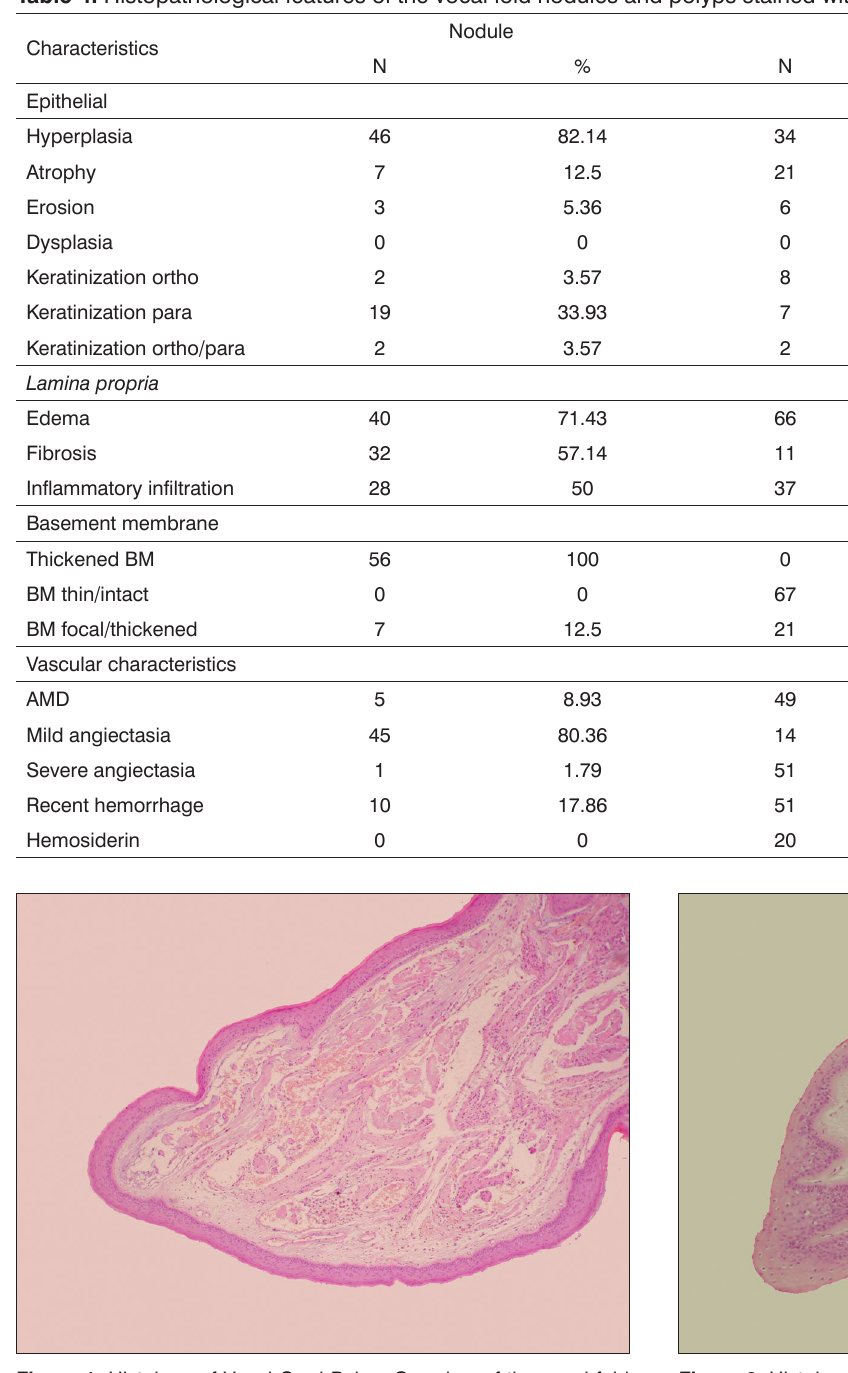
Figure 2. Histology of the Vocal Cord Nodule. Overview of the vocal fold nodule histology stained with hematoxylin and eosin (HE 20x). Presence of hyperplastic epithelium, basement membrane thickening and few changes in the lamina